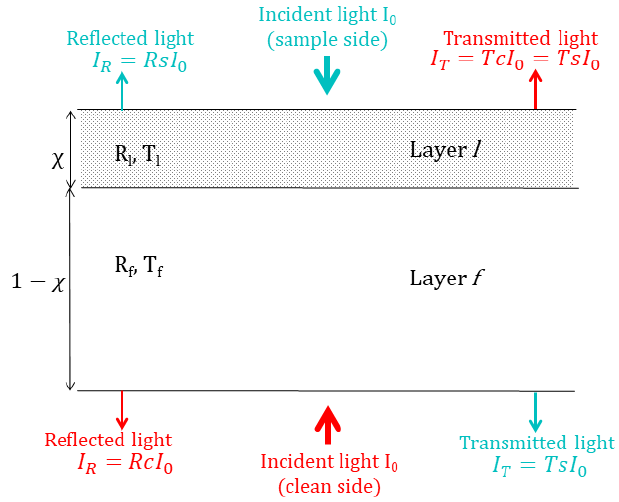
Figure 1. Two-layer model of a filter sample consisting of an aerosol-laden layer “l” and a clean layer “f”.